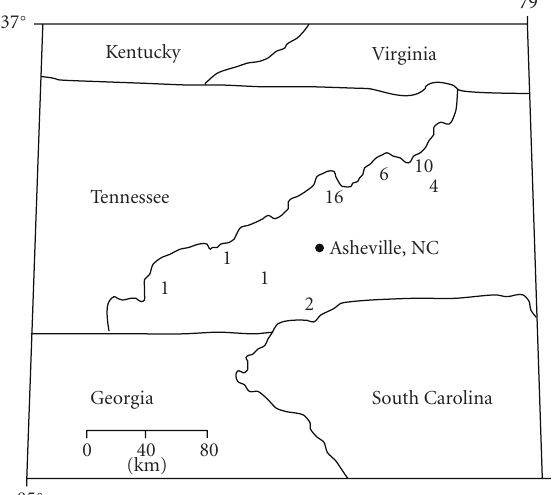
Figure 1: Number of plots and approximate location of stands sam- pled in the Southern Appalachian Mountains of North Carolina, USA.